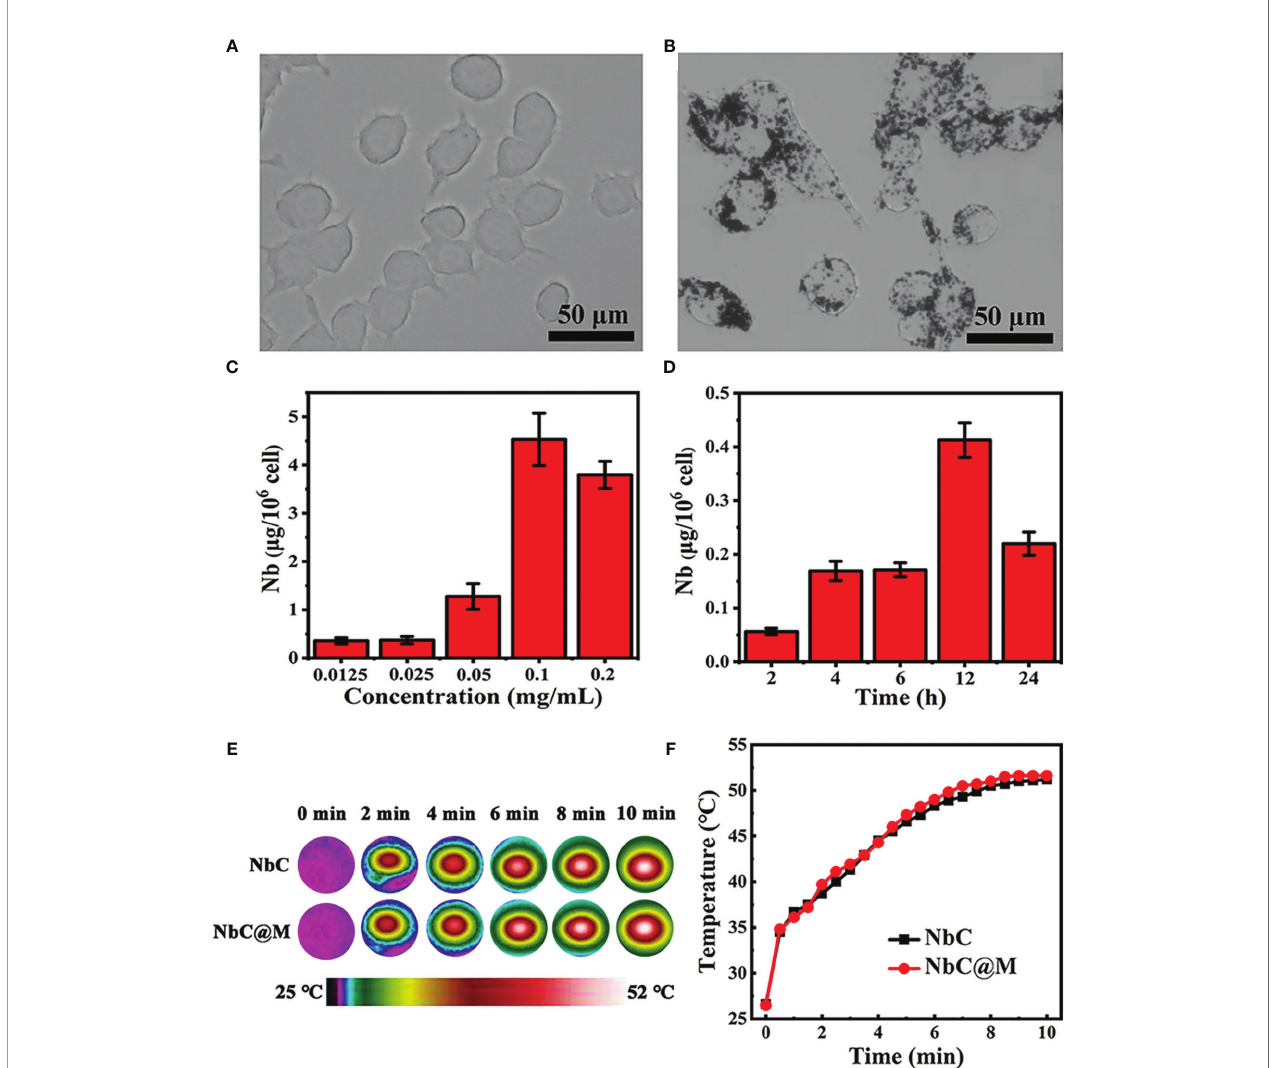
FIGURE 2 | (A) Micrograph of macrophages and (B) NbC nanoparticles loaded macrophages. The in fl uence of (C) concentration and (D) incubation time on intracellular NbC content in macrophage by ICP-MS measurement. (E) Thermography image and corresponding (F) photo-heating curve of the equivalent NbC and macrophage-engulfed NbC